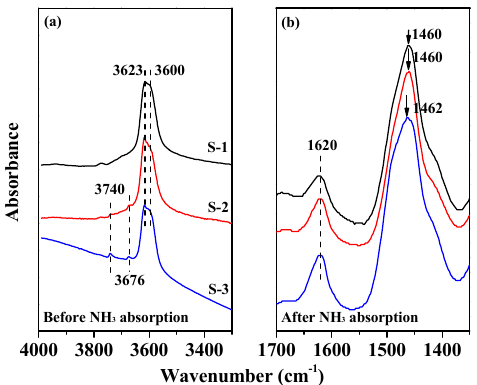
Figure 6. The FT-IR images for different samples at 300 K: ( a ) before NH 3 absorption, ( b ) after NH 3 absorption. Table 4. The B and L acid distribution of zeolite samples.